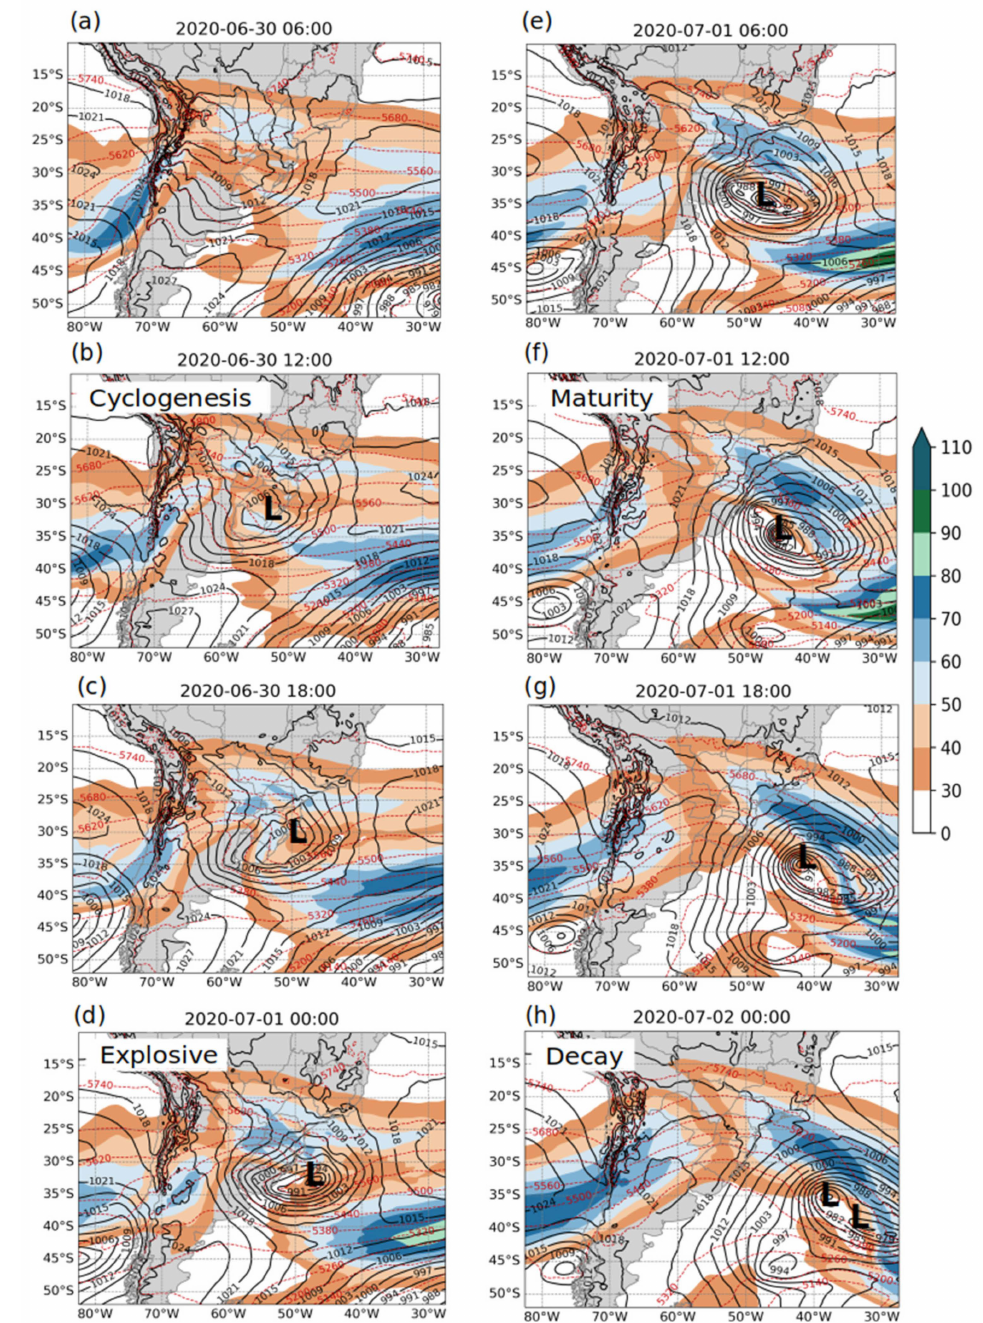
Figure 3. Synoptic chart from 0600 UTC 30 June 2020 to 0000 UTC 02 July 2020 ( a – h ). PNMM is represented in black lines with intervals of 3 hPa, 500–1000 hPa thickness (mgp, dashed red lines), and wind intensity at 250 hPa greater than 30 m s − 1 (color). The letter L indicates the position of the center of the